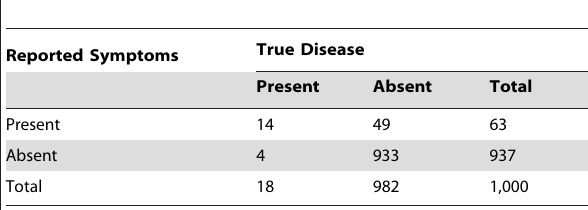
Table 3. Distribution of cases of ‘‘true pneumonia’’ according to caregiver report of ‘‘suspected pneumonia’’ (test) and true disease status when test sensitivity is 80% and specificity is